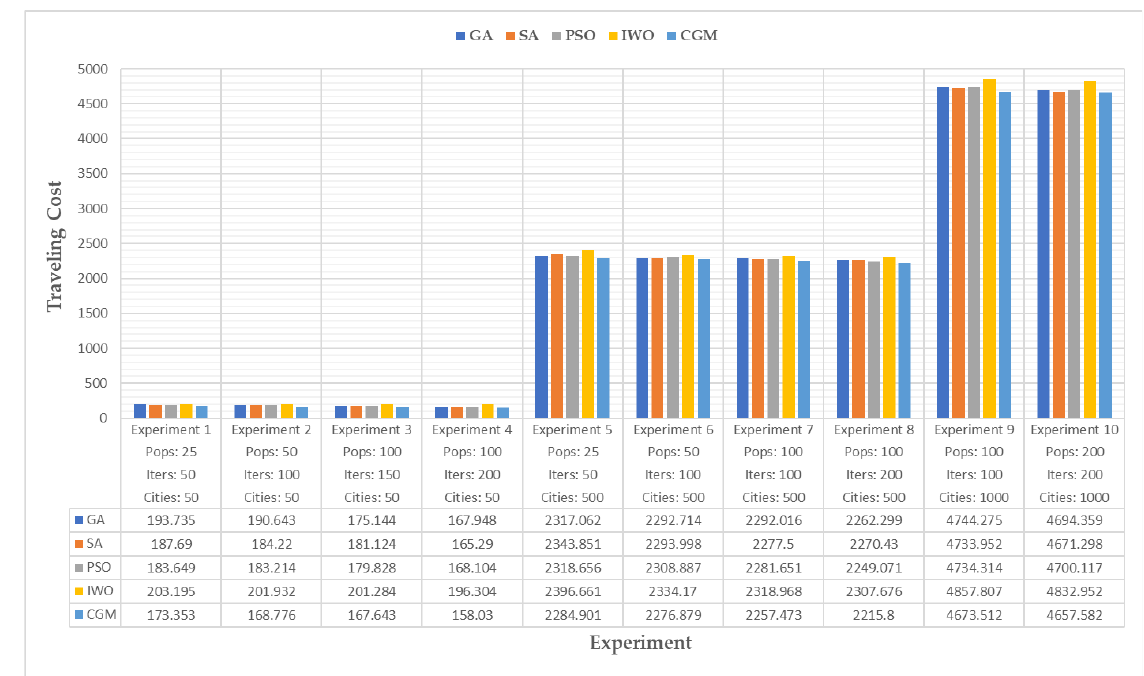
Figure 4. Evaluation results of the traveling salesman problem (random dataset).